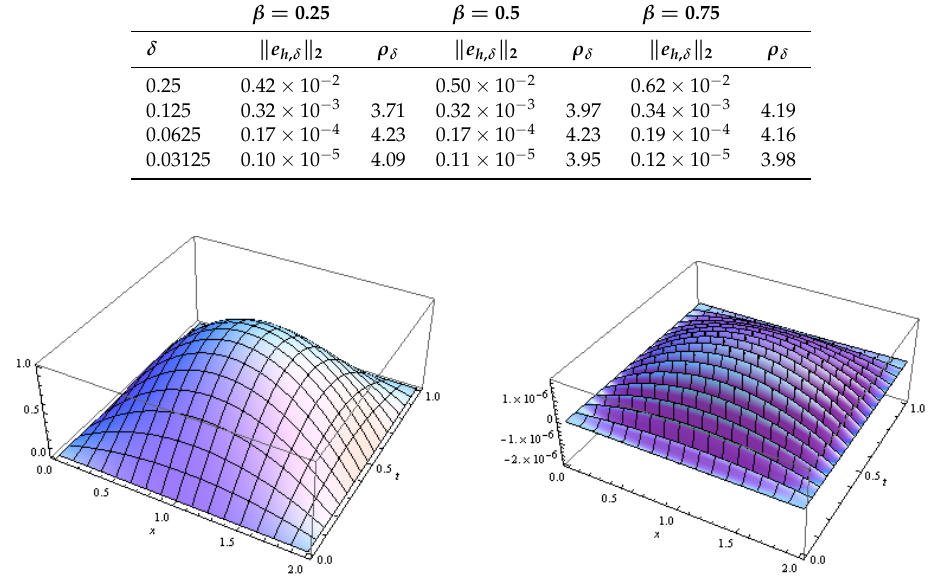
Figure 3. Test 2: ( a ) the numerical solution and ( b ) the error in the case when β = 0.25 and δ = 0.03125, s = 2 δ , h =